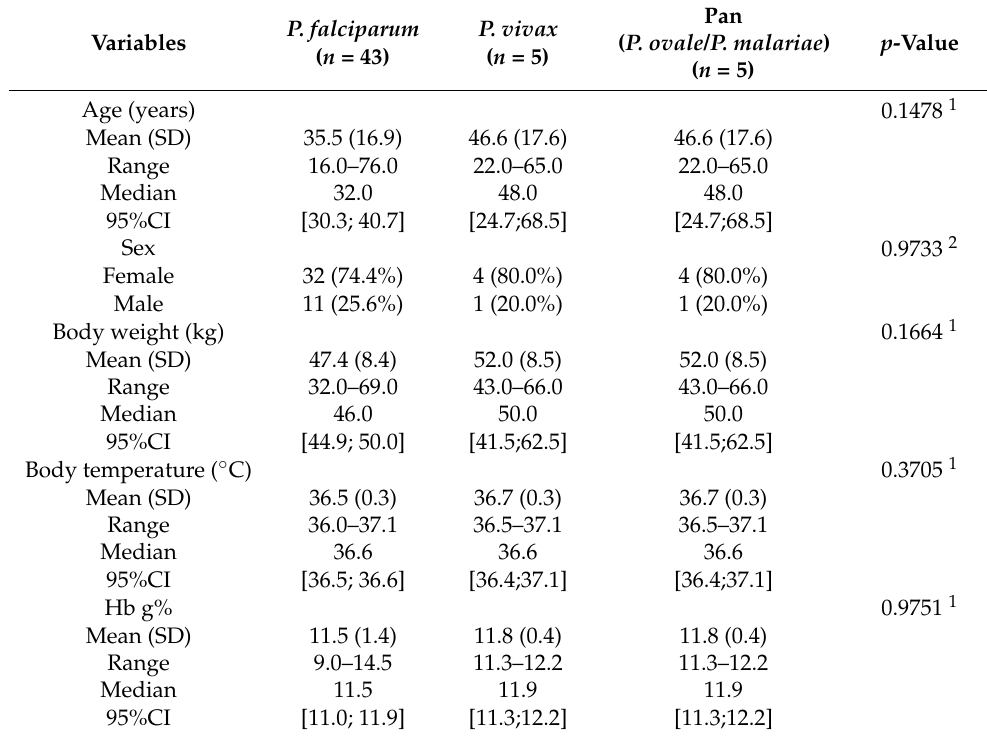
Table 4. Adults with mRDT (+) ( n =